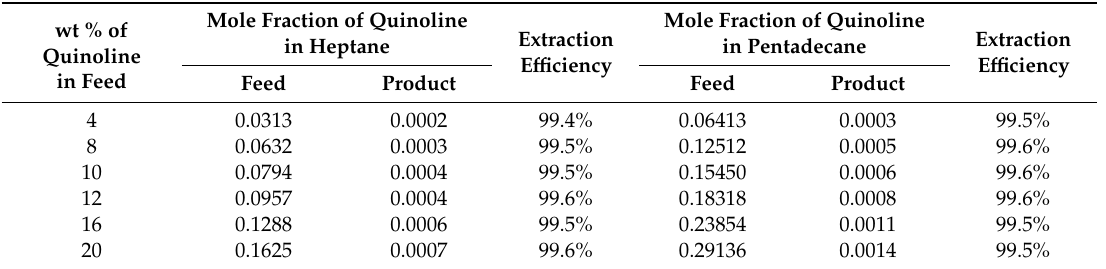
Table7. Summary of quinoline’s extraction efficiency at different concentration in heptane and